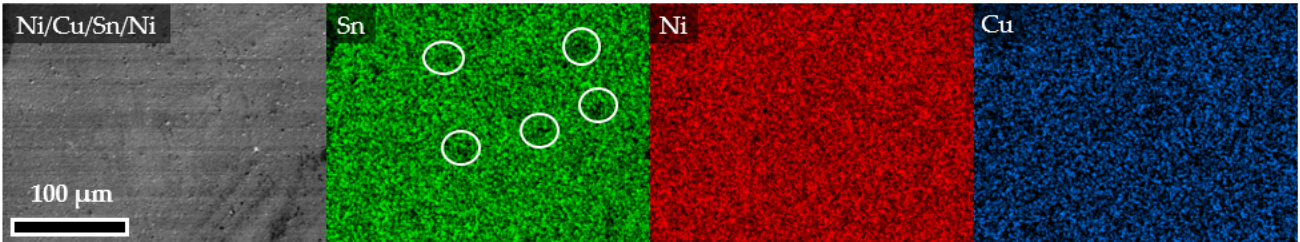
Figure 2. The top view of the SEM and EDX mapping images of the Ni/Cu/Sn/Ni precursors.